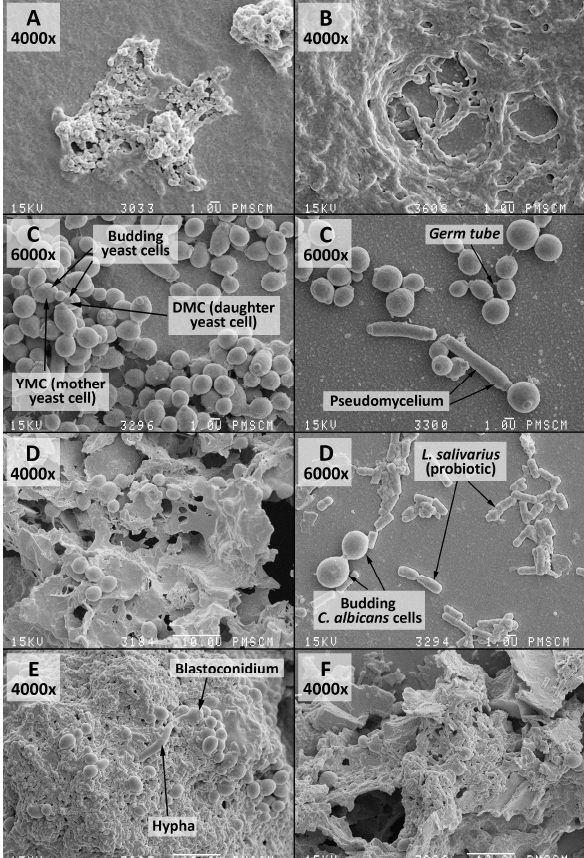
Figure 5. SEM images of the mono-species biofilm, generated by S. mutans , C. albicans and the double-species oral streptococci/yeasts biofilm—untreated and treated with the Lactobacillus salivarius (HM6 Paradens)—after 24 h of biofilm formation. ( A ) The 14 h S. mutans biofilm formed on a flat agar surface (Agar Scientific, Stansted, UK). S. mutans adheres to the polystyrene surface, mainly using a sucrose-dependent mechanism; ( B ) The 24 h S. mutans biofilm formed on a flat agar surface; visible polymeric Extracellular Matrix (ECM), which has an open architecture with nutrient channels, and other properties; ( C ) The 24 h C. albicans biofilm formed on a flat agar surface (Agar Scientific, Stansted, UK). C. albicans adheres to the polystyrene surface, mainly using mycelial forms, visible pseudohyphae, budding yeast, and the so-called germ tube, considered to be the key features of the pathogenicity of the fungus. The culture was maintained at 36 ◦ C, pH 7.0 and pCO 2 5%, in bovine serum as a medium additive promoting growth of the culture in the presence of a sucrose substrate (5%); ( D ) The 24 h C. albicans biofilm formed on a flat agar surface (Agar Scientific, Stansted, UK) under the influence of Lactobacillus salivarius (HM6 Paradens). There was no clear, compact structure for the C. albicans biofilm and single loosely located budding cells. Other morphological forms of yeasts were invisible; ( E ) The 24 h double-species oral streptococci/yeasts biofilm formed on a flat agar surface (Agar Scientific, Stansted, UK). There was an apparent change in the C. albicans morphotype in the S. mutans common culture and visible pleomorphic forms were true hyphae and, blastoconidia, which in the mixed culture also produce mycelial forms, whose role is related to damage to immune cells (macrophages), leading to microorganism invasion. There was abundant extracellular matrix between cells and covering bacterial and yeast cells. Bacterial cells were visible in chains adhering to yeast cells and wrapped around them; ( F ) The 24 h double-species S. mutans / C. albicans biofilm formed on a flat agar surface (Agar Scientific, Stansted, UK) under the influence of Lactobacillus salivarius (HM6 Paradens). There was no clear, compact S. mutans / C. albicans biofilm structure or single loosely located budding cells. Other morphological forms of C. albicans were invisible. There was no visible extracellular matrix. Original magnification: 4000 × and 6000 ×